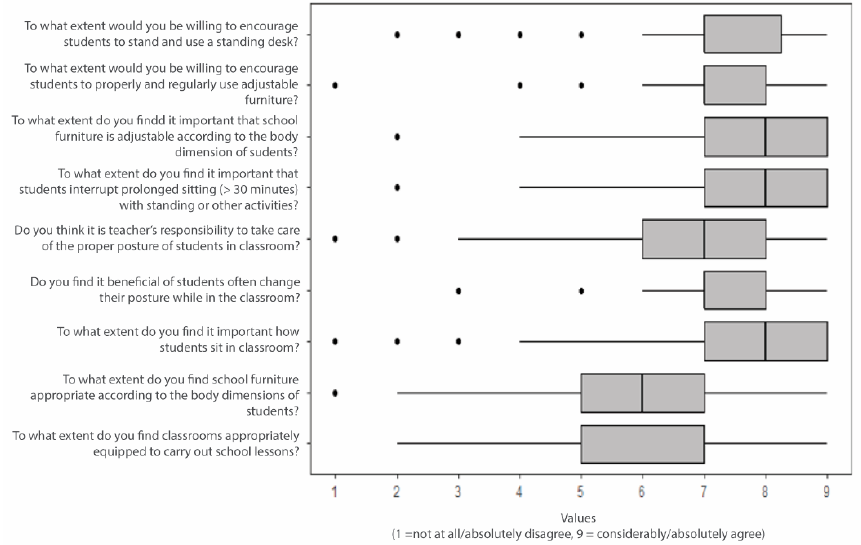
Figure 1. Teachers’ responses from the survey. The box presents the interquartile range (IQR), from the 25th (Q1) and 75th (Q3) percentile. The horizontal line presents the minimum (Q1 − 1.5*IQR) and the maximum (Q3 + 1.5*IQR) value in the data. Bold lines represent the median values, and points present potential outliers.